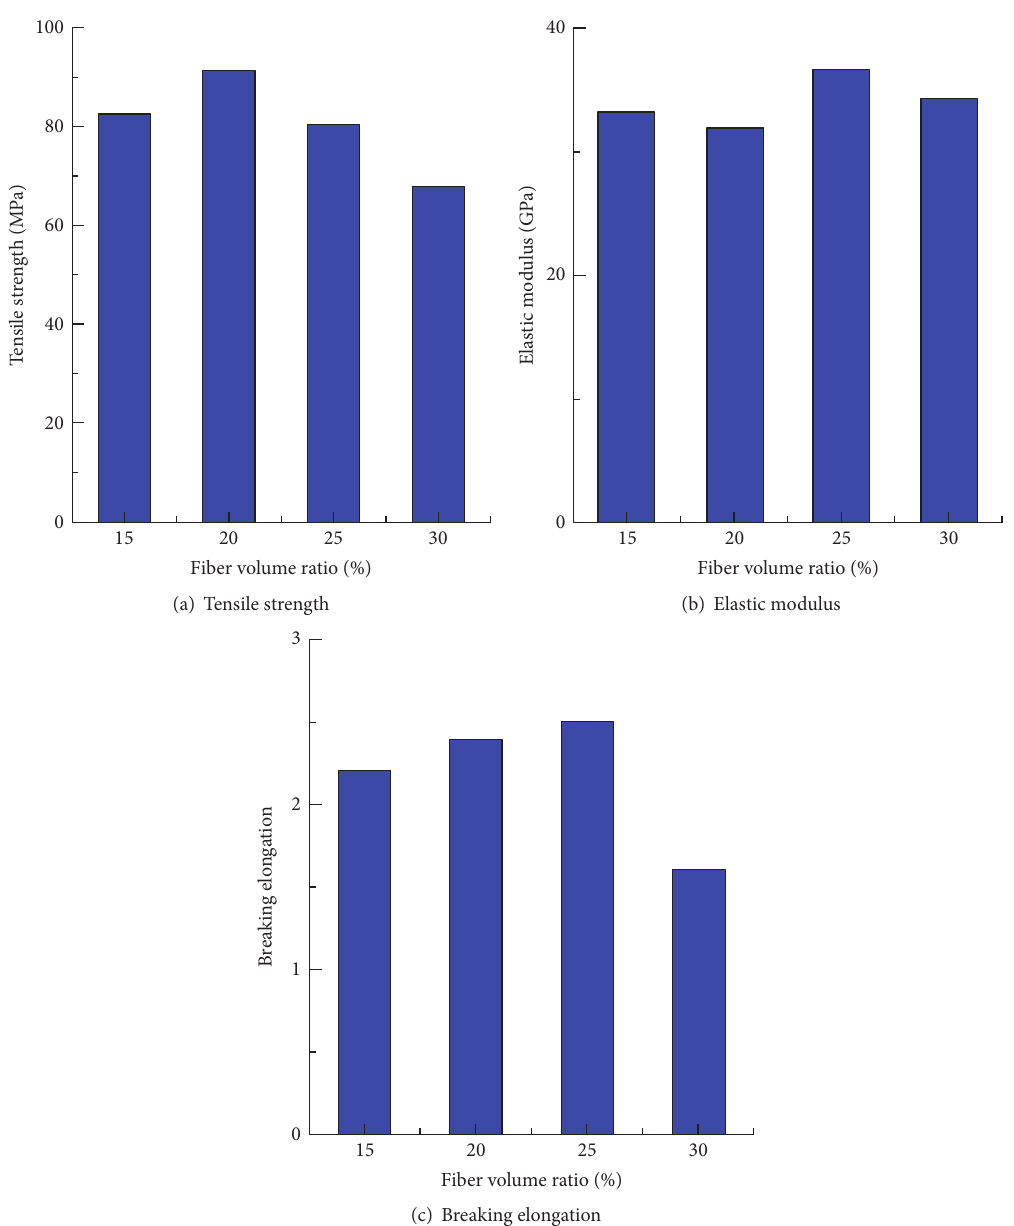
Figure 13: Comparison of tensile properties of sprayed FRP in different fiber volume ratios.